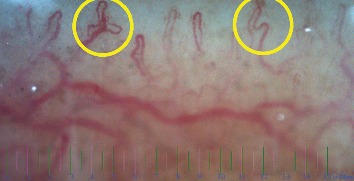
Nail fold capillaroscopic changes in an 8 years old girl with juvenile systemic lupus erythematosus and C1q complement. Central nervous system involvement (motor developmental delay) and skin lesions were presented at 2 years old as the first manifestations. Loss of density (<7/mm) and branch pattern were demonstrated in the nail fold capillaroscopy of this patient.